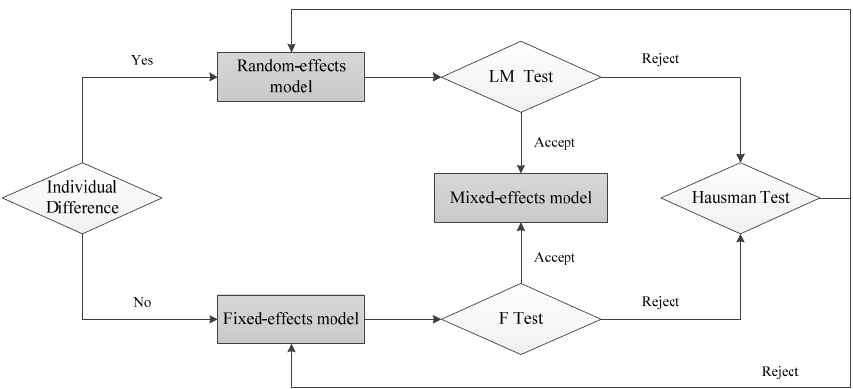
Figure 5. The flow chart of the panel data analysis model examination.